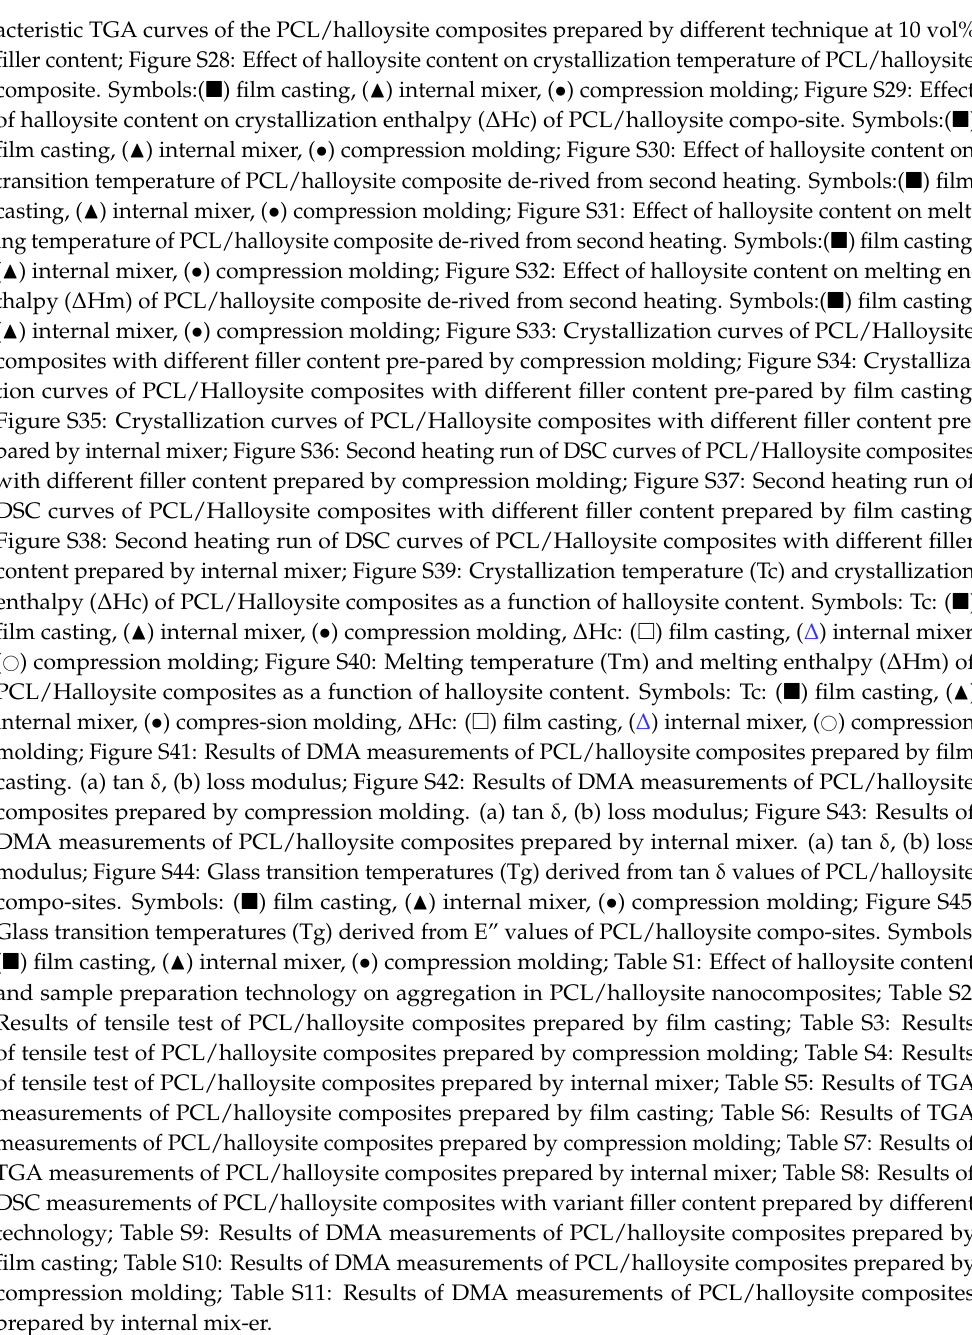
technology; Table S9: Results of DMA measurements of PCL/halloysite composites prepared by film casting; Table S10: Results of DMA measurements of PCL/halloysite composites prepared by compression molding; Table S11: Results of DMA measurements of PCL/halloysite composites prepared by internal